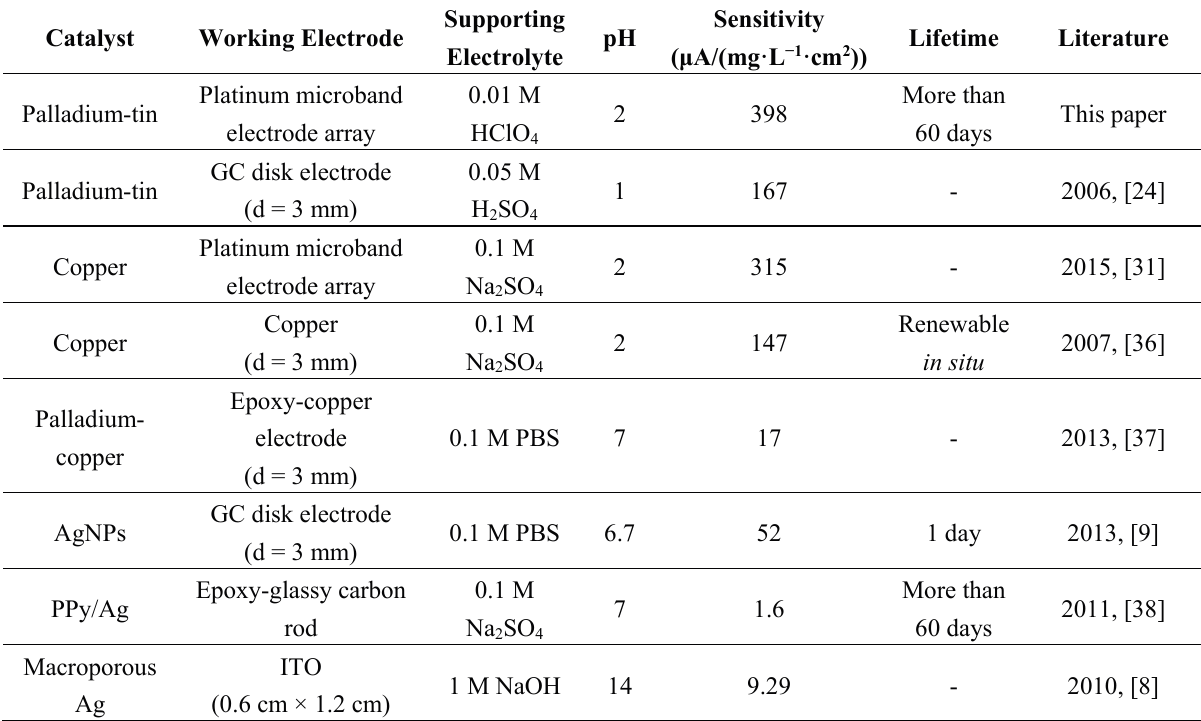
Figure 8. Analytical performance of the same electrode after different days-storage. Table 1. Comparison of analytical performance of some electrochemical nitrate